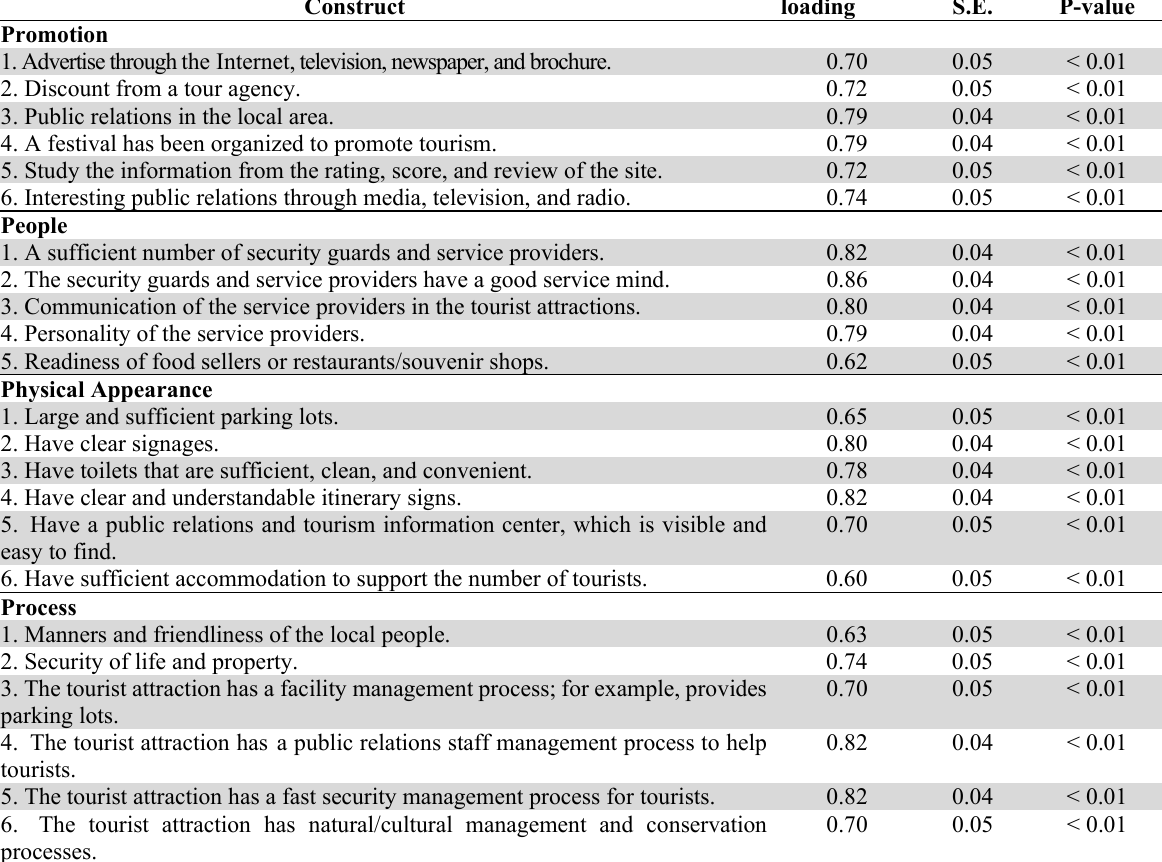
Convergent validity of the reflective latent measurement model